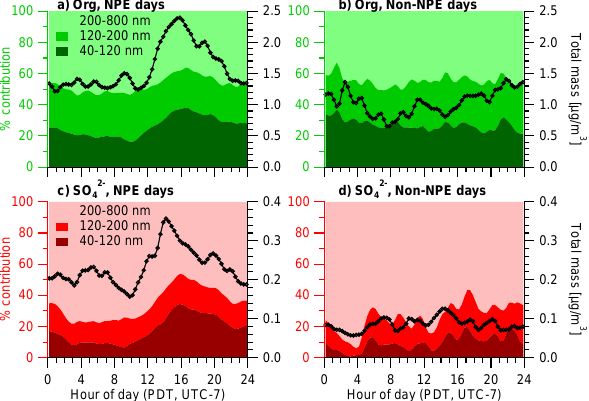
Figure 7. Diurnal patterns of the concentrations of (a, b) Org and (c, d) SO 2 − (black circles and lines, right y -axes) and the mass 4 fractions in the range 40–120, 120–200 and 200–800nm (in D va , left y -axes) during NPE days (left panel) and non-NPE days (right panel) at T1.